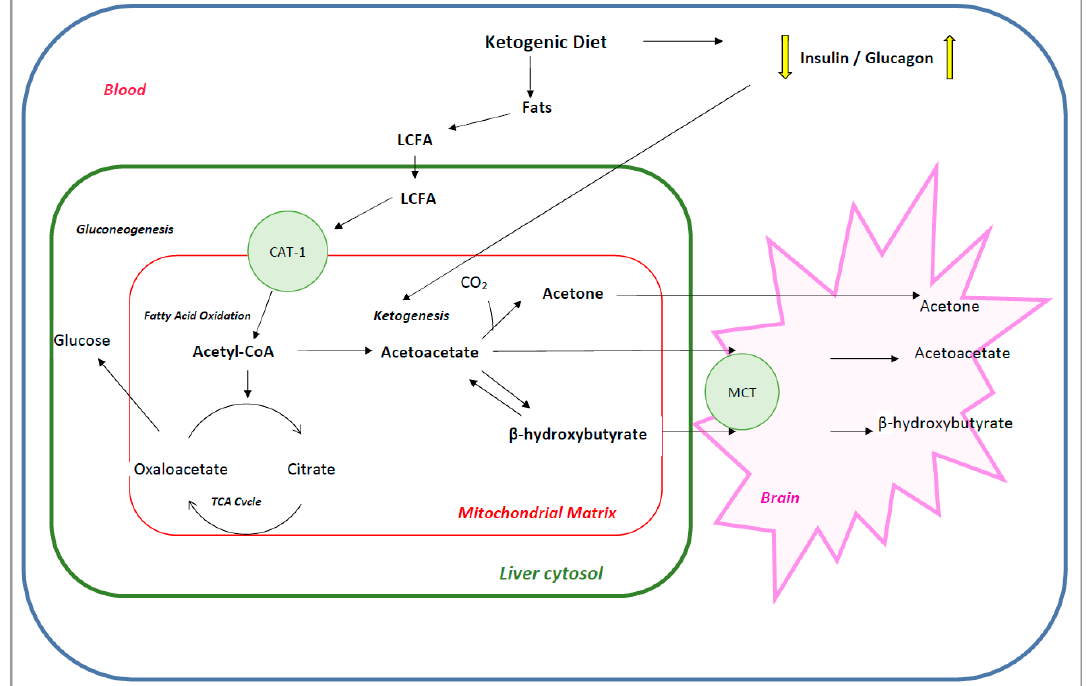
Figure 1. Depiction of liver cytosol metabolism that lead to ketone bodies formation penetrating to the brain (detailed description in the text). Abbreviations: CAT—carnitine-acylcarnitine translocase, LCFA—long-chain fatty acids, MCT—monocarboxylic acid transporter, TCA—tricarboxylic